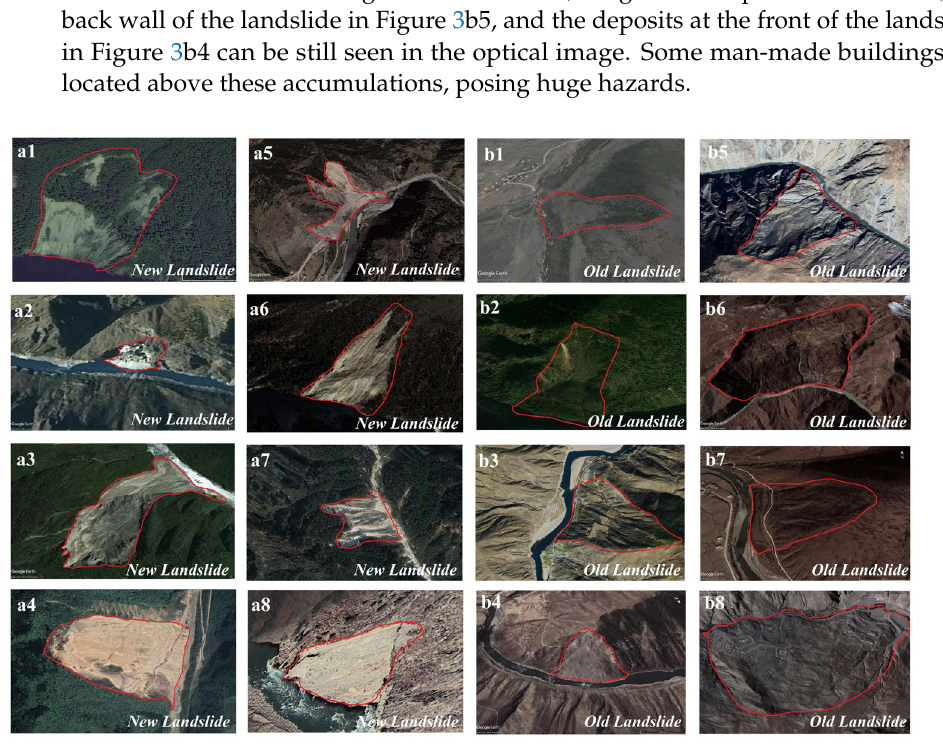
Figure 3. The landslide instances in the LRSTTC dataset. ( a1 – a8 ) are new landslides that just occurred recently; ( b1 – b8 ) are old landslides that occurred for a long time.